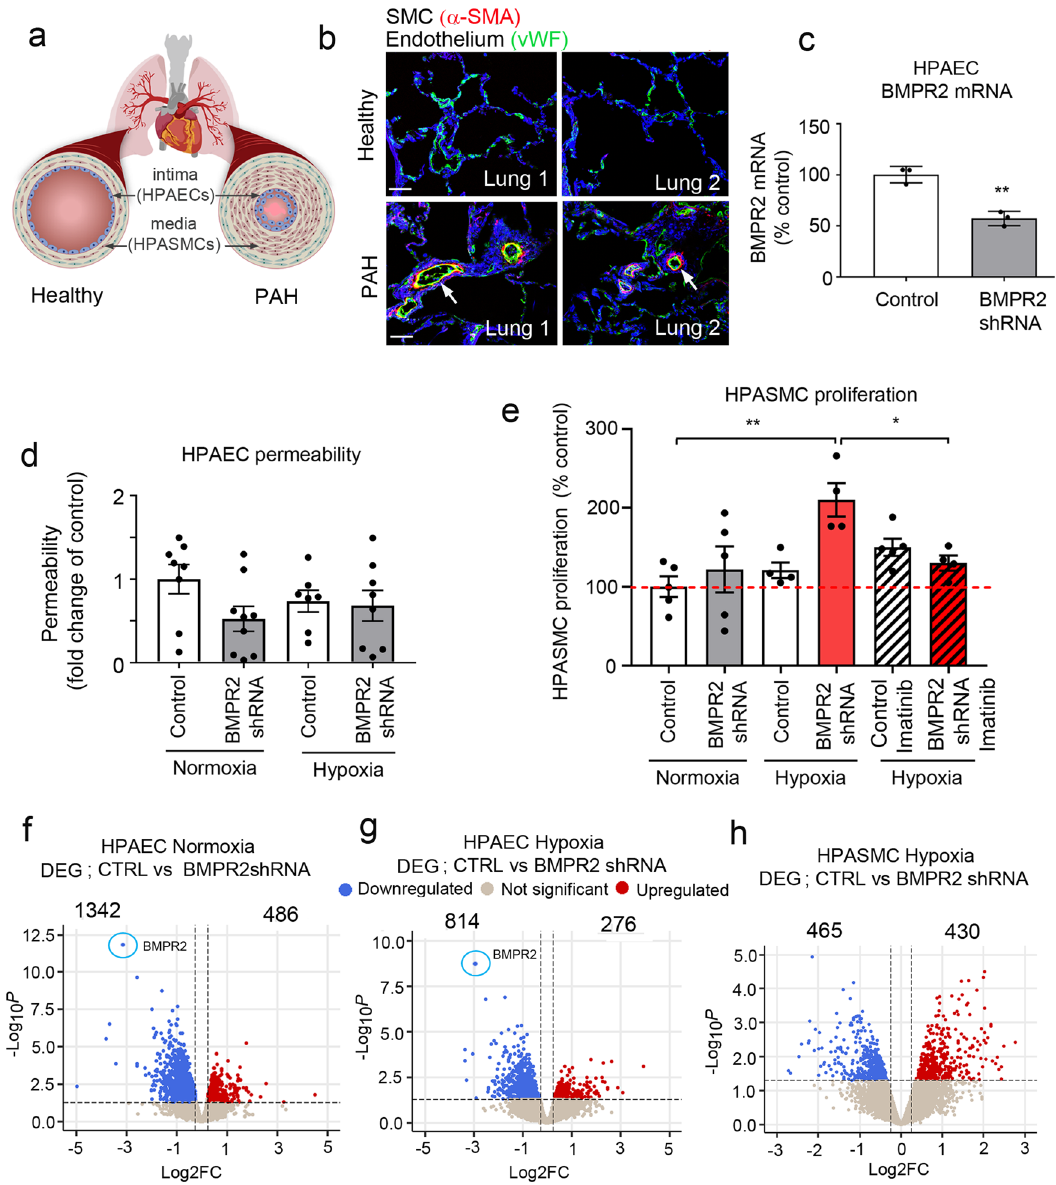
Fig. 2 Two-hit model of PAH in pulmonary artery-on-a-chip. a Schematic diagram of pulmonary vascular remodelling in PAH. b α -SMA (red) and vWF (green) staining in healthy and PAH lungs. Bar = 50 µ m. c BMPR2 mRNA expression in HPAECs treated AdCTRLshRNA with Ad-BMPR2-shRNA-GFP. n = 3; ** P < 0.01; unpaired t -test. d Effect of two-hit (hypoxia and BMPR2 knockdown, 24 h) on HPAEC permeability, measured as the passage of 40 kDa FITC-dextran (1 mg/mL) from top to bottom channel; n = 9 individual chips. e Effect of hypoxia and endothelial BMPR2 knockdown on HPASMC proliferation (24 h, EdU assay). Cells were untreated or treated with 10 µ M Imatinib mesylate for 24 h. n = 4 – 5 individual chips. In d , e error bars are mean ± SEM; one-way ANOVA with Tukey post-hoc correction test. Volcano plots show differentially expressed genes (DEG) in f HPAECs treated with BMPR2shRNA, g HPAECs in the two-hit PAH model (BMPR2 shRNA and hypoxia), h HPASMCs in the two-hit PAH model. Downregulated genes are in blue and upregulated genes are in red; P < 0.05, 0.25-fold cut-off. n =